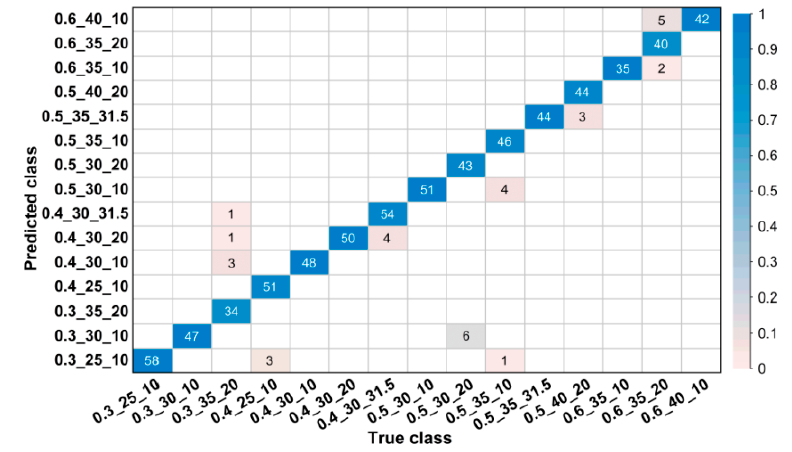
Figure 4. Confusion matrix for validation set of Net- Ⅰ.